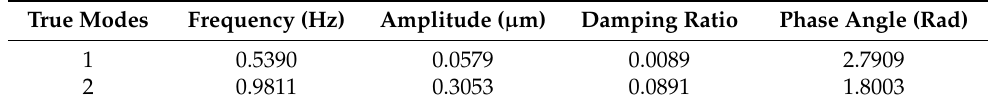
Table 12. Modal parameters matching results of real-time